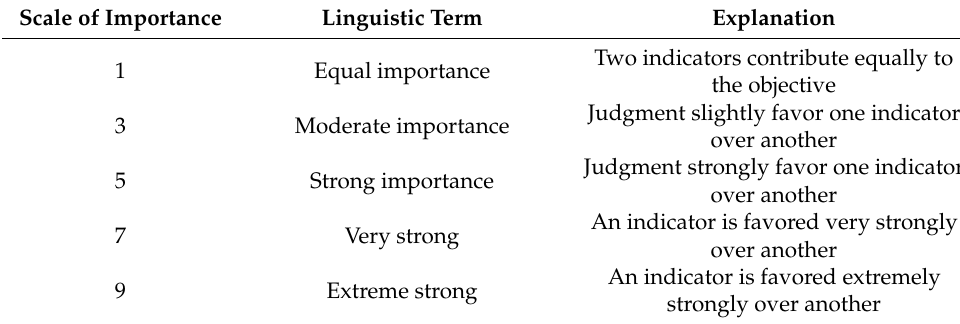
Table 1. Saaty’s scale.